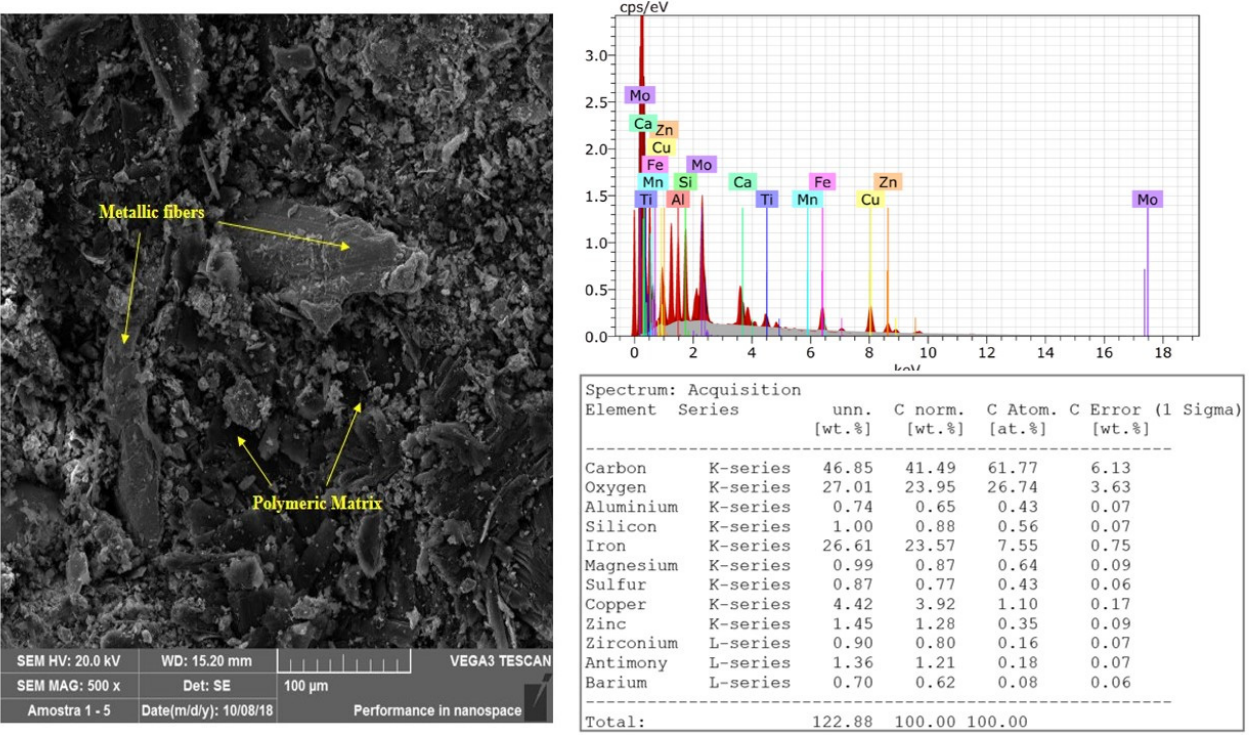
Figure 3. SEM images—500 × —and EDS estimation of the chemical composition.